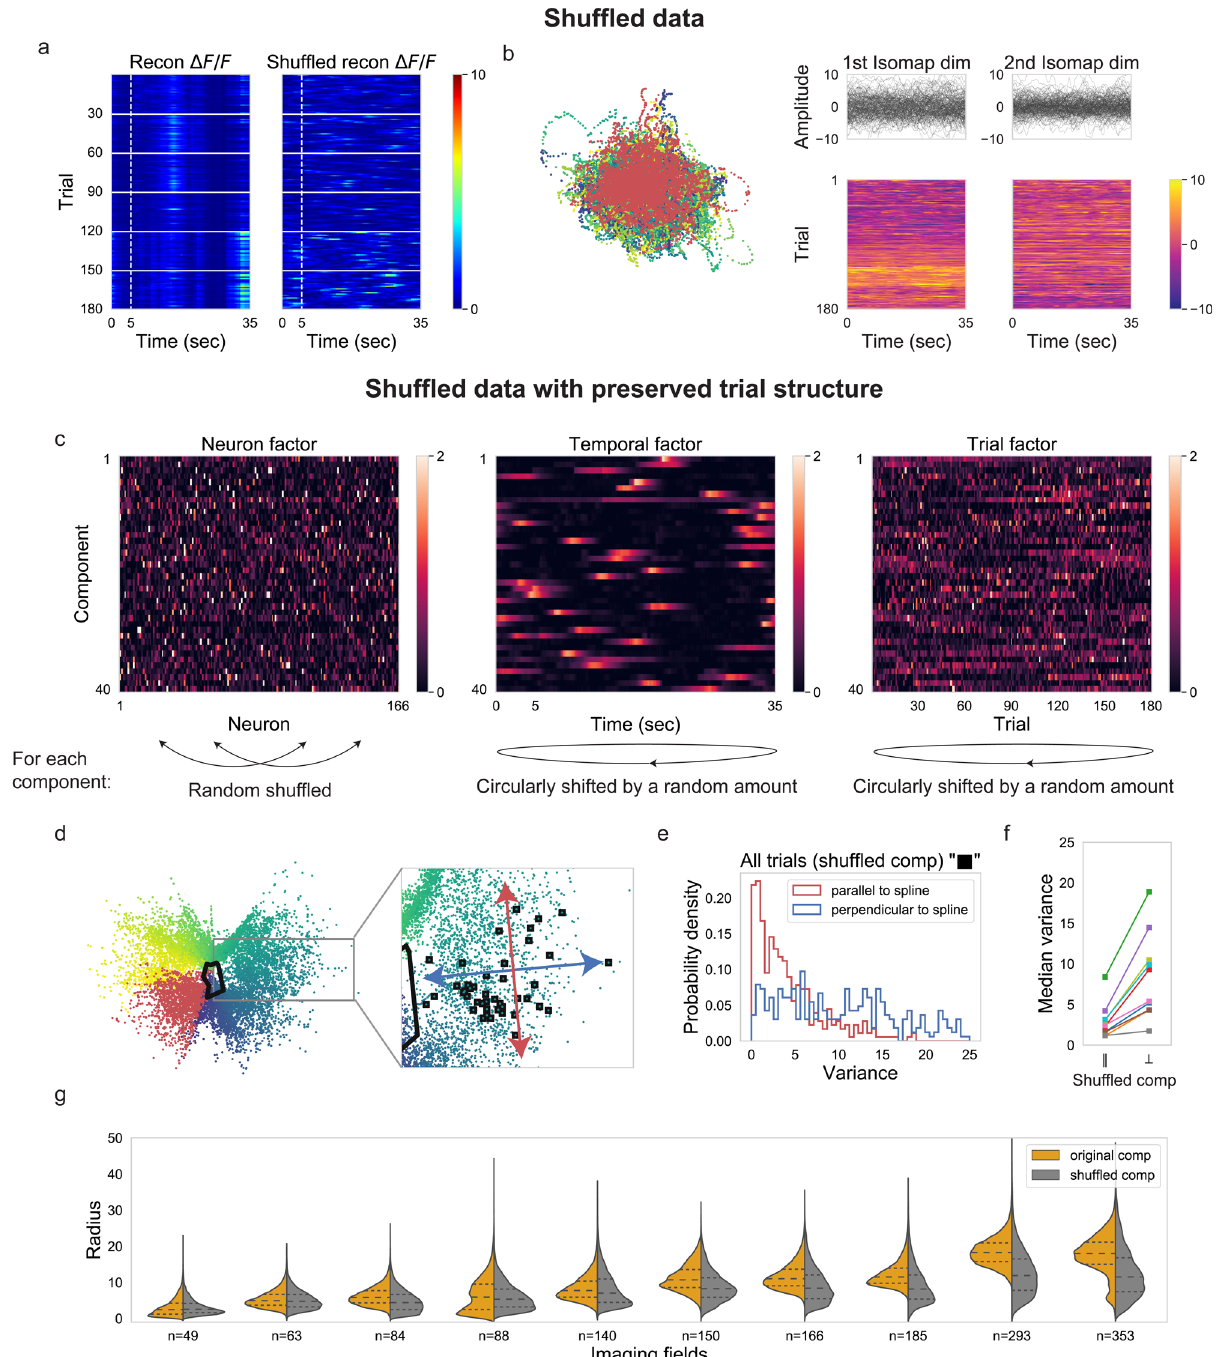
continued to be largely constrained to the direction perpendicular to the spline (Fig. 7d). The smaller variability of population activity parallel to the spline is visible in the separation of dots of different colors, where color indicates the time in the trial of the instantaneous population activity (Fig. 7d). Indeed, the quanti- fi cation of variance showed that the amplitude of neural variability along the spline was signi fi cantly smaller than that perpendicular to the spline (Fig. 7e). Moreover, the signi fi cant difference between variance along the direction parallel and perpendicular to the spline held for shuf fl ed data with preserved trial structure from all the imaging fi elds (Fig. 7f). In conclusion, the fact that episodic activity is precise in time across trials